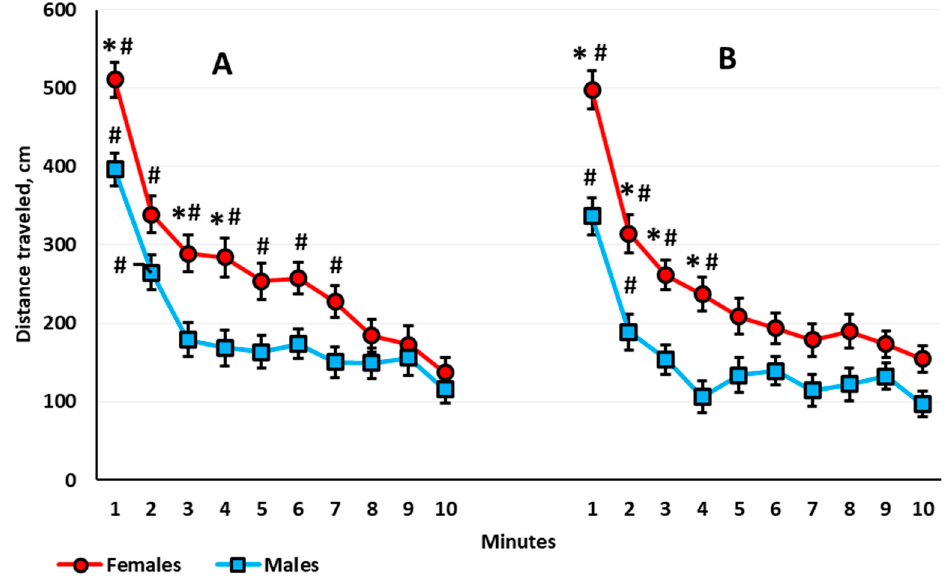
Figure 3. The distance traveled (cm) by female and male rats over 10 min in the automated open field test; ( A ) 3-month-old rats and ( B ) 8.5-month-old rats. The * indicates a statistically significant di ff erence compared with the distance traveled in the males of the same age at the same minute, p ≤ 0.004; the # means p ≤ 0.015 compared with the distance traveled in the tenth minute by the rats of the same age and sex (ANOVA followed by the Newman–Keuls post hoc test). See Supplementary Materials, Table S2.